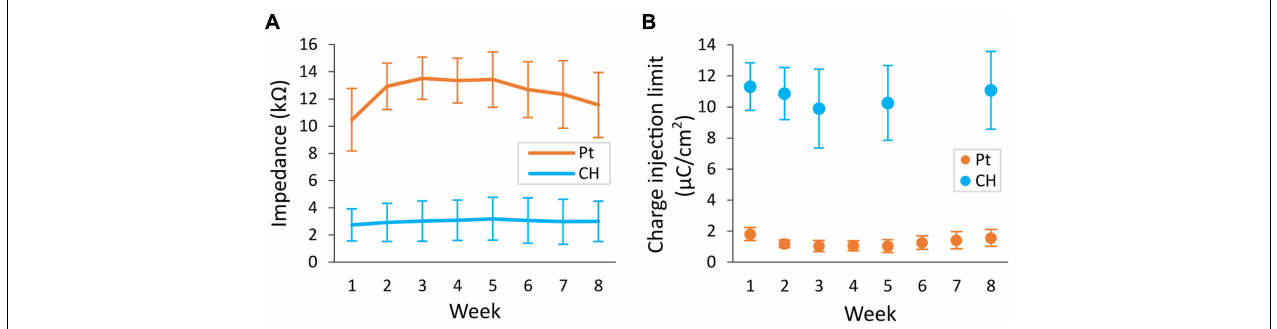
FIGURE 6 | Voltage transient (VT) impedance and charge injection limit (CIL) measured in the rat brain. Conductive hydrogel-coated electrodes (CH) or uncoated platinum electrodes (Pt) were implanted in rat brains and electrochemical testing was performed weekly for 8 weeks. The maximum current that can be applied before reaching the potential for water reduction (E mc = –0.6 V) was measured as CIL. VT impedance was calculated from the peak voltage in the first phase of response to fixed current of 100 µ A delivered at 100 µ s pulse width. Both graphs represent mean ± SD. (A) VT impedance was significantly lower in CH compared with Pt ( p < 0.001, three-way ANOVA, 36 CH electrodes, 48 Pt electrodes) across all electrode contacts for the duration of the study. There was significant effect of duration of implantation in Pt ( p < 0.001), increasing in the first 2 weeks and decreasing in the final 2 weeks. (B) CIL was significantly higher in CH compared with Pt